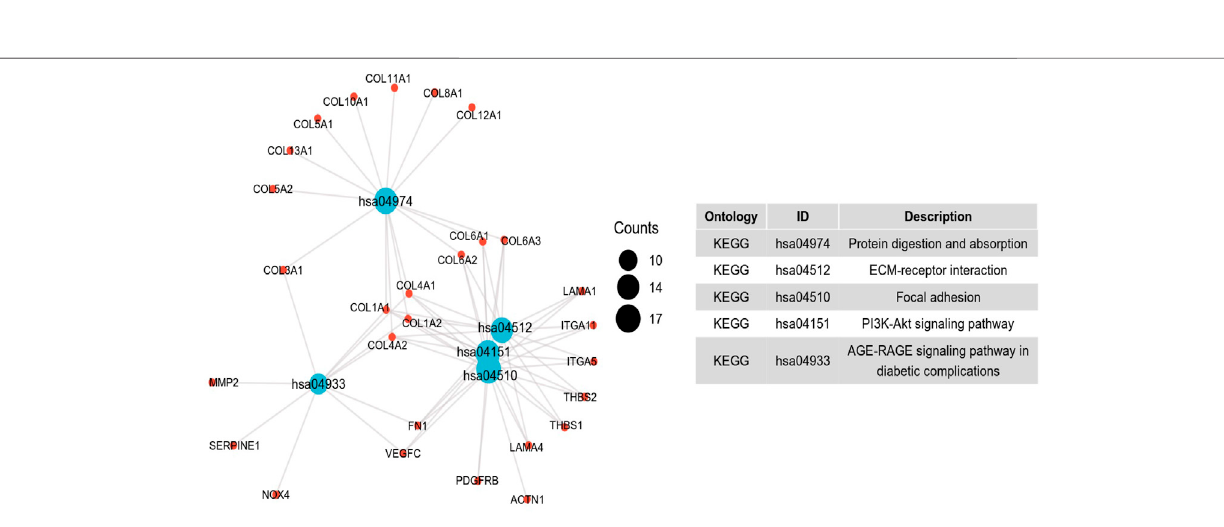
Frontiers in Genetics |